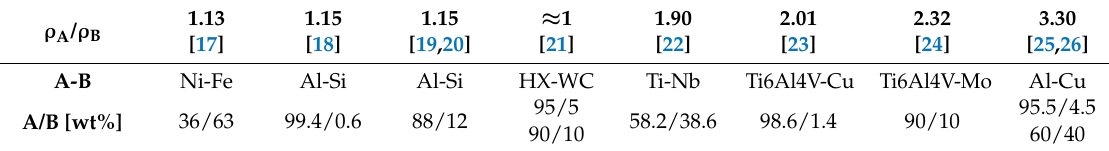
Table 1. Summary of literature on LBM in situ alloying of microscaled powder mixtures.